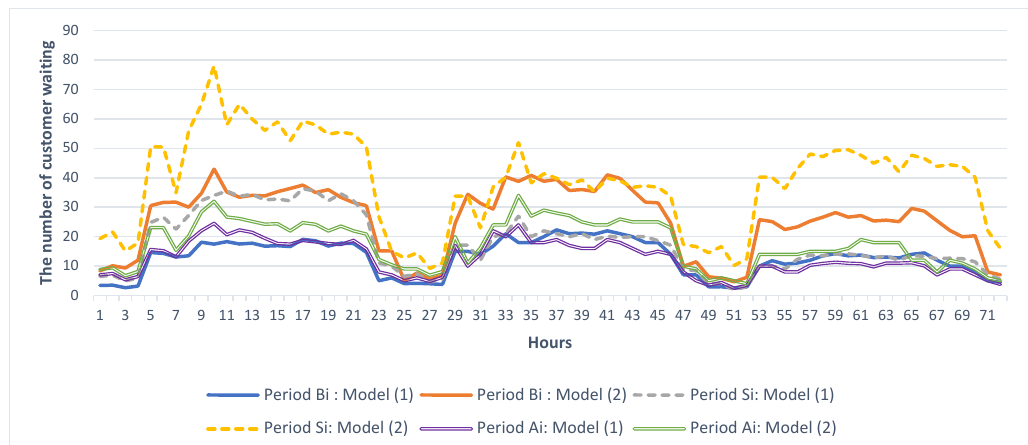
Figure 10. The number of customers waiting by periods.